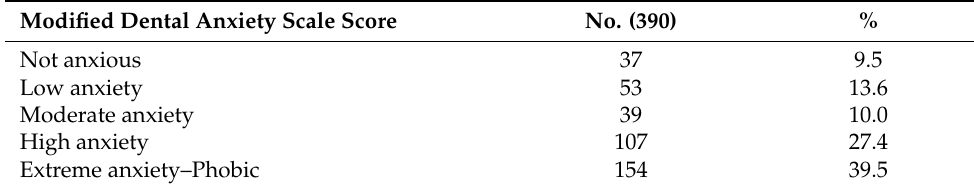
Table 4. Modified Dental Anxiety scale score (MDAS) of the studied older adults.